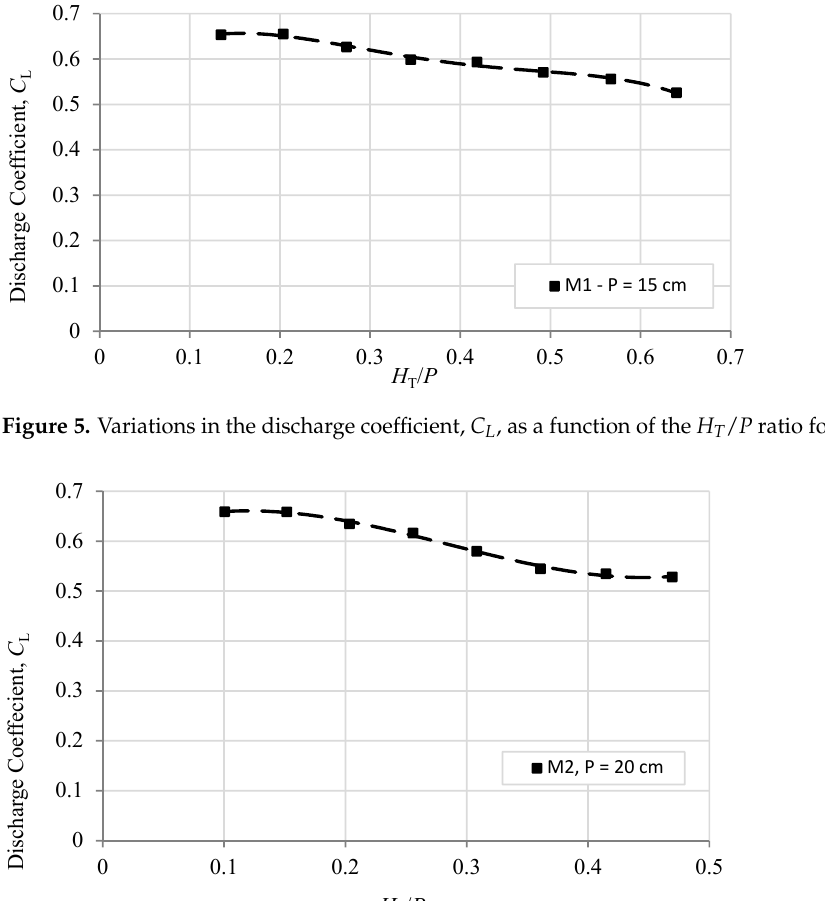
Figure 7. Variations in the discharge coefficient, C L , as a function of the H T /P ratio for the M3 model.